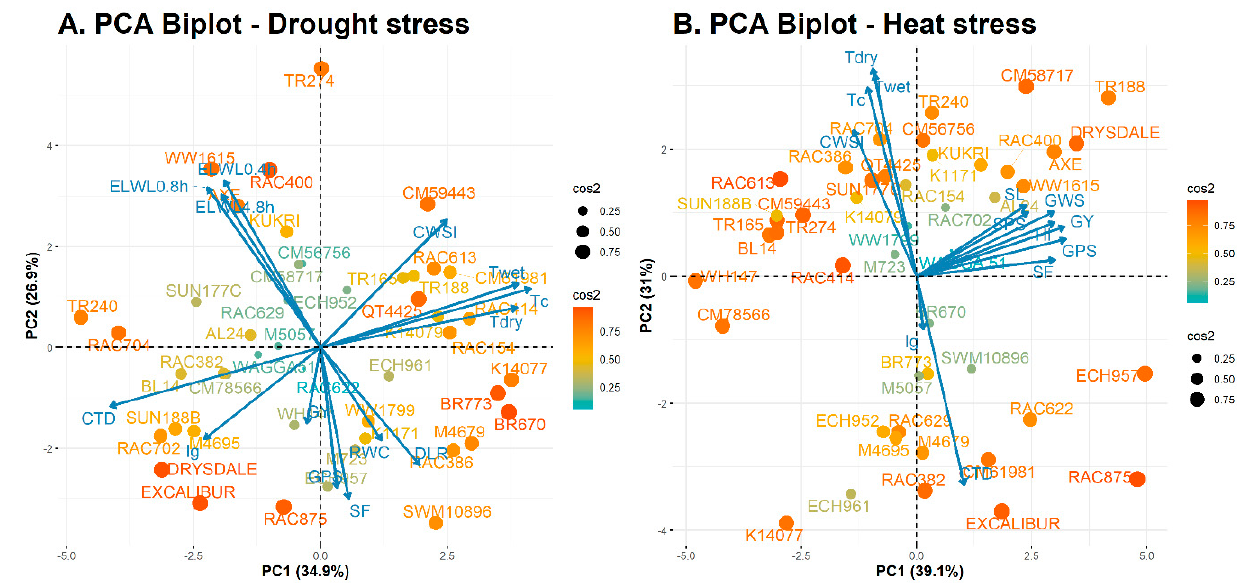
Figure 5. Principal component biplot showing genotype-by-trait interrelationship for ( A ) drought and ( B ) heat-stressed experiment. The magnitude of genotype-by-trait interrelationship represents by squared cosine (cos 2 ) on the factor.